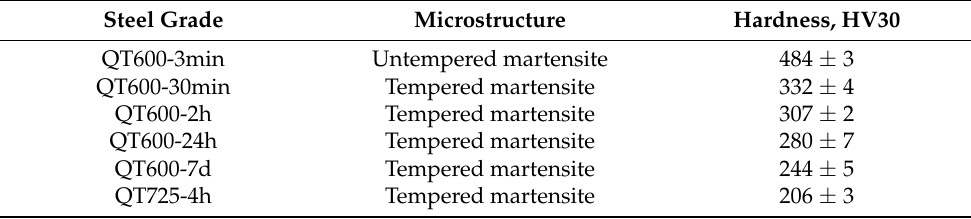
Table 3. Chemical composition (weight %) of the 42CrMo4 steel used in this